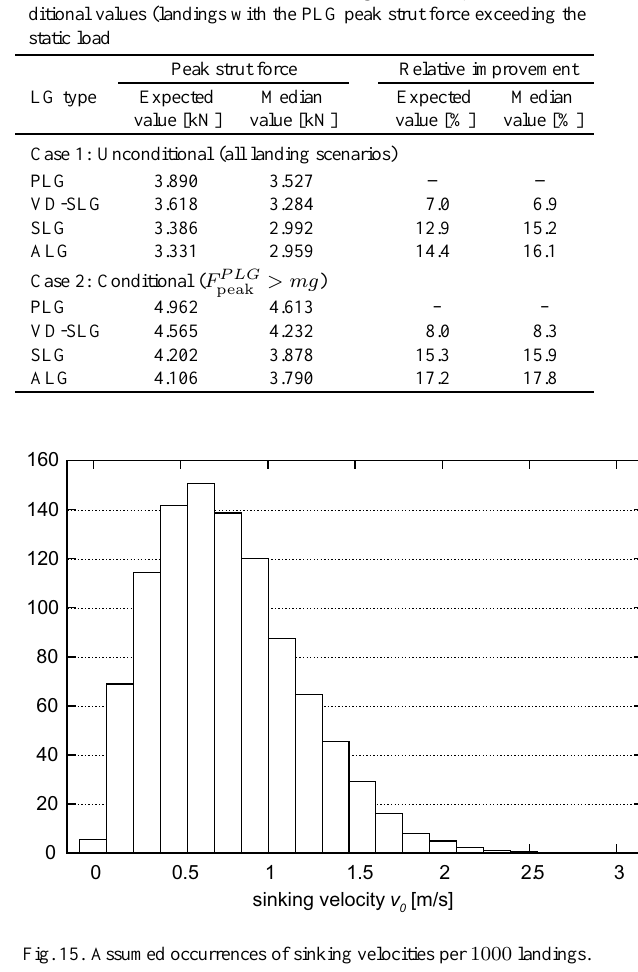
Table 3 Performance of four LG control strategies, a statistical comparison.